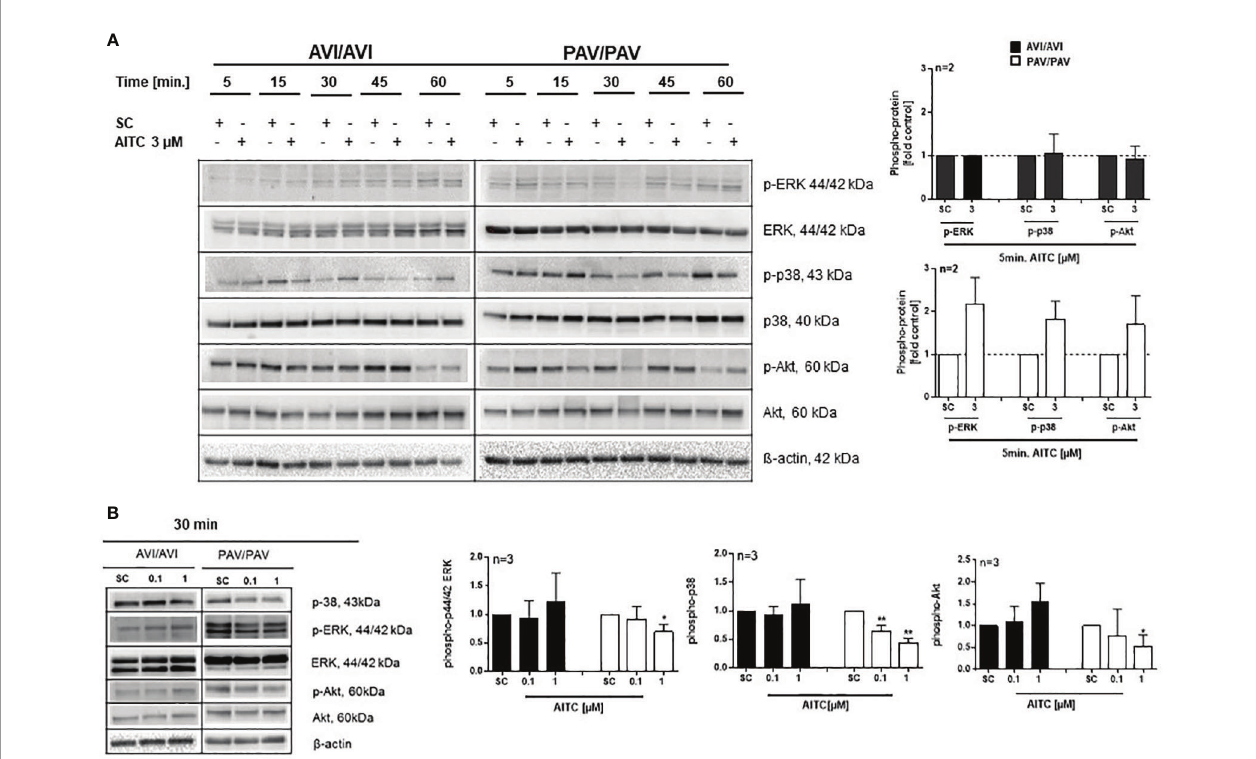
FIGURE 4 | AITC mediates MAPK down-stream signaling in dependence of the TAS2R38 haplotype. (A , B) PBMC were treated with test compounds for the indicated time points and pellets were collected for protein expression analysis. Representative immunoblots are given. Densitometric analysis was done to quantify the immunoblots using Quantity One software (Bio-Rad, Munich, Germany) and normalized against b -actin, which was used as loading control. The graphs show phosphorylated ERK1/2, p-38 or Akt, protein levels relative to control as quanti fi ed by pixel densitometry. Bars are mean + SD; *p < 0.05, **p < 0.01 (n ≥ 2). Signi fi cance of difference was calculated relative to the corresponding solvent control determined by one-way ANOVA (SC, 0.01%